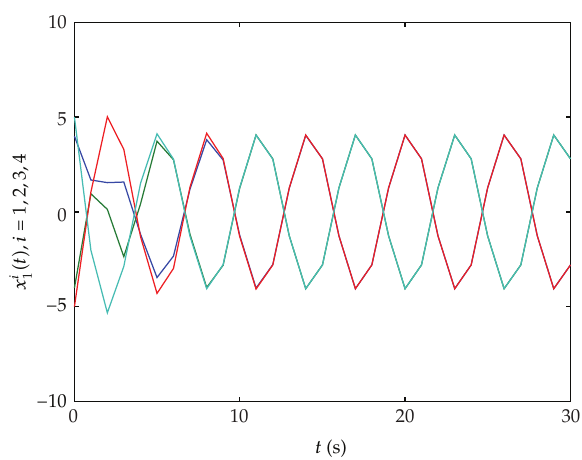
(cid:6) t (cid:7) , i (cid:9) 1 , 2 , 3 , 4 for G 1